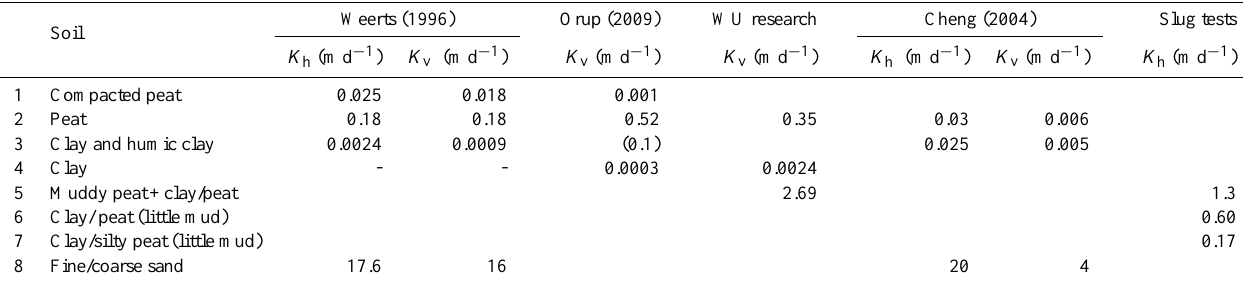
Table 2. Horizontal and vertical hydraulic conductivity from different sources.